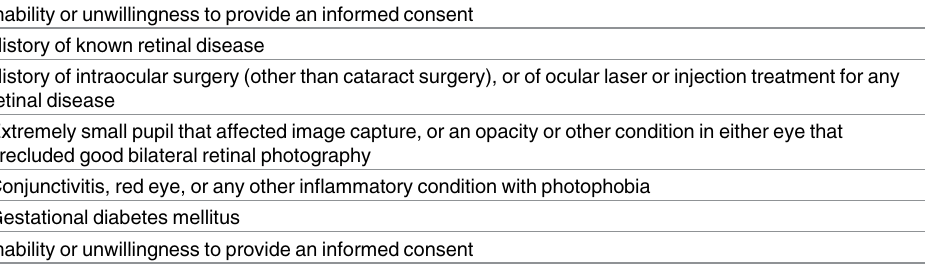
Table 2. Exclusion